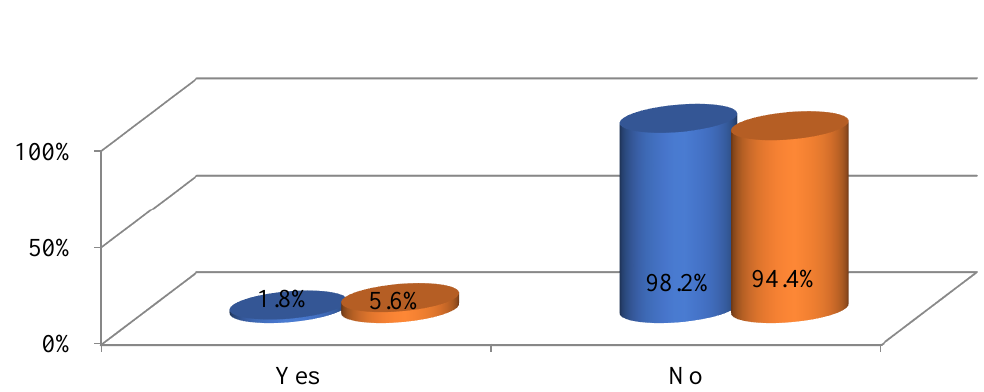
Figure 2. Percentage of nurses and paramedics using psychological help. More than half of the nurses could not state explicitly whether the problem of occupa- tional burnout concerned their group (57.2%). Among the paramedics, 31.8% of respondents could not assess whether they suffer from burnout syndrome. On the other hand, it was the paramedics (38.3%) who admitted that they noticed symptoms of burnout in themselves. Compared to the results obtained in the group of nurses, this was a significant percentage of affirmative responses (Figure 3).